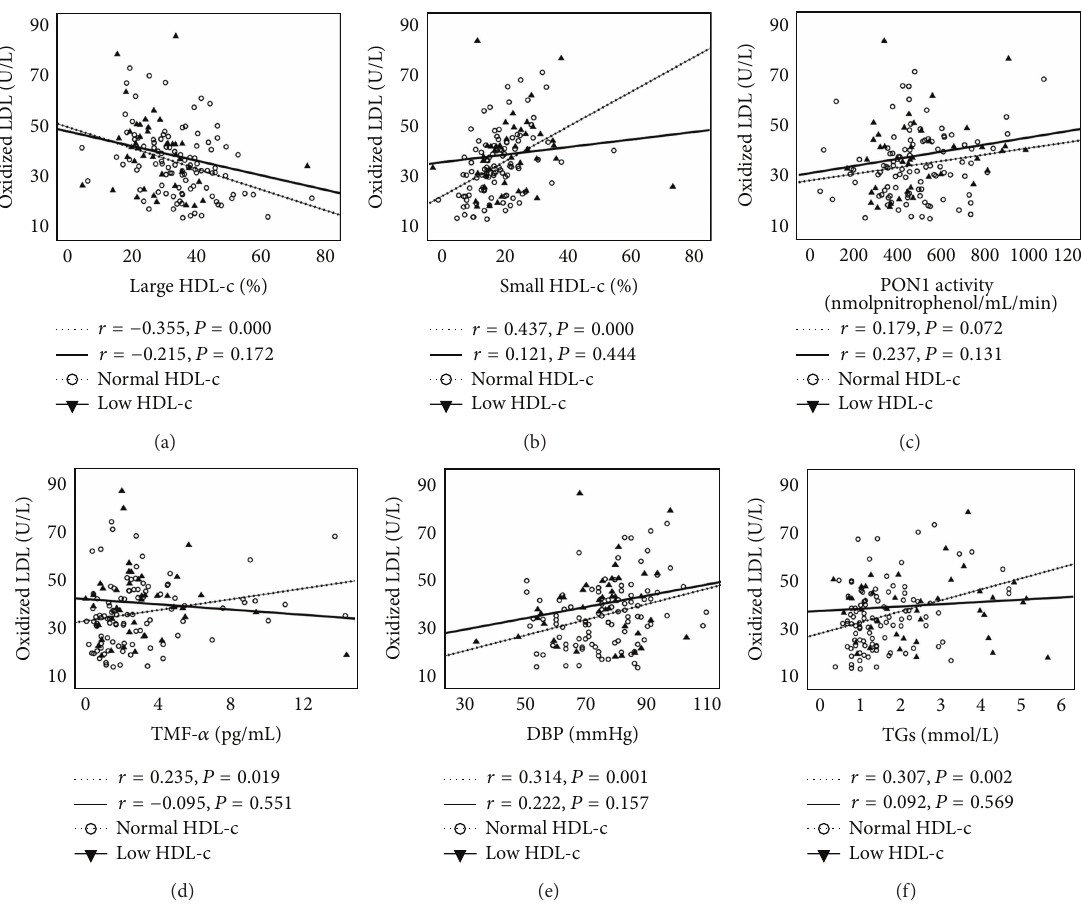
Figure 4: Main correlations in normal and low HDL-c patients. Correlation between Ox-LDL-c and large HDL-c (a), small HDL-c (b), PON1 activity (c), TNF- 𝛼 (d), DBP (e), and TGs